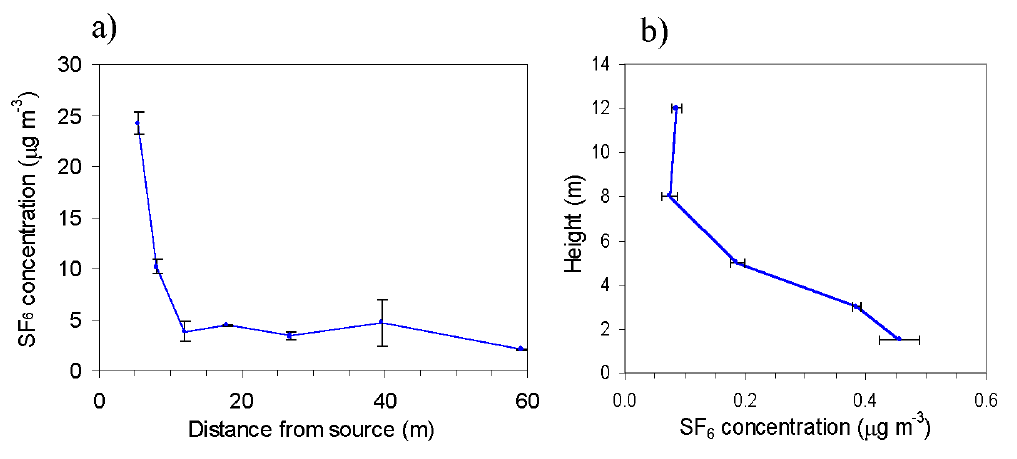
FIGURE 9. Values of the tracer ratio ( r ) for (a) a horizontal transect at 1.5 m above ground and (b) a vertical transect at 45.2 m from source. Error bars are ± 1 standard error calculated from standard errors of ammonia and SF